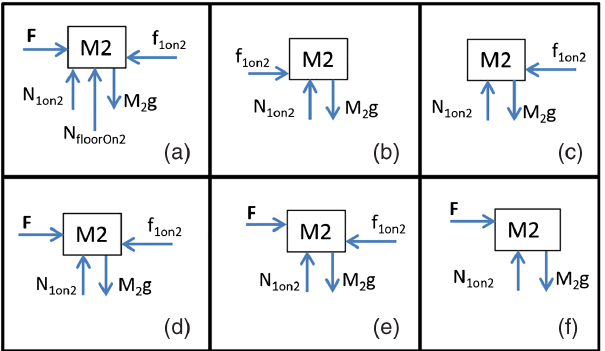
FIG. 8. Answer choices given for question 1 on version A of week 7, level 1 problems.